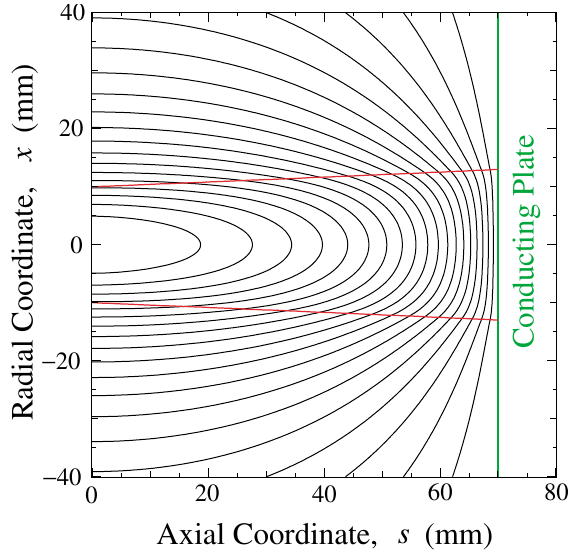
FIG. 7. (Color) Self-field potential contours of (cid:14) and statistical beam envelope R of a WARP PIC simulation of a midpulse axisymmetric beam near a conducting plate. Contours in (cid:14) are in the x - z plane ( y (cid:1) 0 ) and are equally spaced in volts, and the statistical envelope projections x (cid:1) (cid:26) R (cid:1) (cid:26) 2 h x 2 i 1 = 2 shown in red. Beam parameters correspond to those in Table